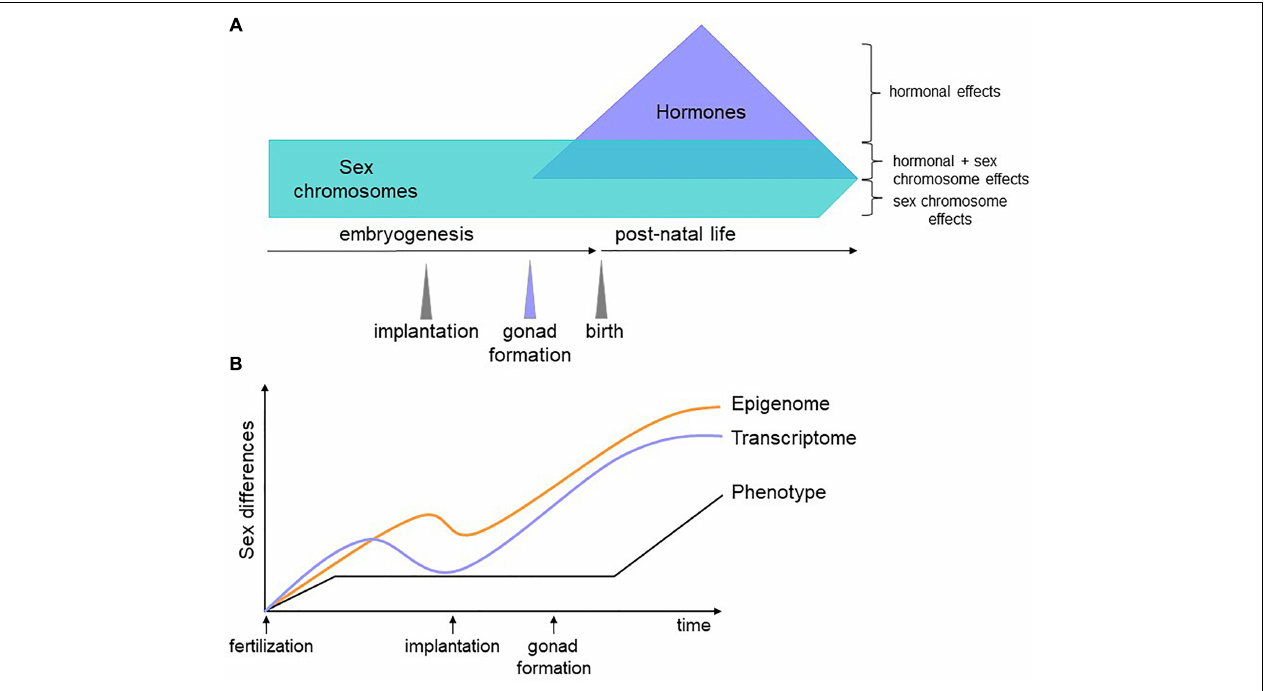
FIGURE 2 | Schematic of our hypothesis. (A) Sex biases have different origins depending on the developmental stage of the organism. Before gonadogenesis, sex chromosomes are the primary determinants of sex differences. Sex hormones influence the transcriptome and epigenome independently of and in combination with sex chromosome effects. (B) Soon after fertilization, male and female cells have sex-specific transcriptomes, epigenomes, and phenotypes (for example, male embryos grow faster than female embryos). At implantation, lineage determination begins and gene expression differences are reduced. Epigenetic marks, however, are less constrained and some are maintained, affecting gene expression, and phenotype later in development. Once specific lineages are established, differences in gene expression increase again due to environmental, hormonal and genetic factors, some of which act on sex-specific epigenetic features established prior to